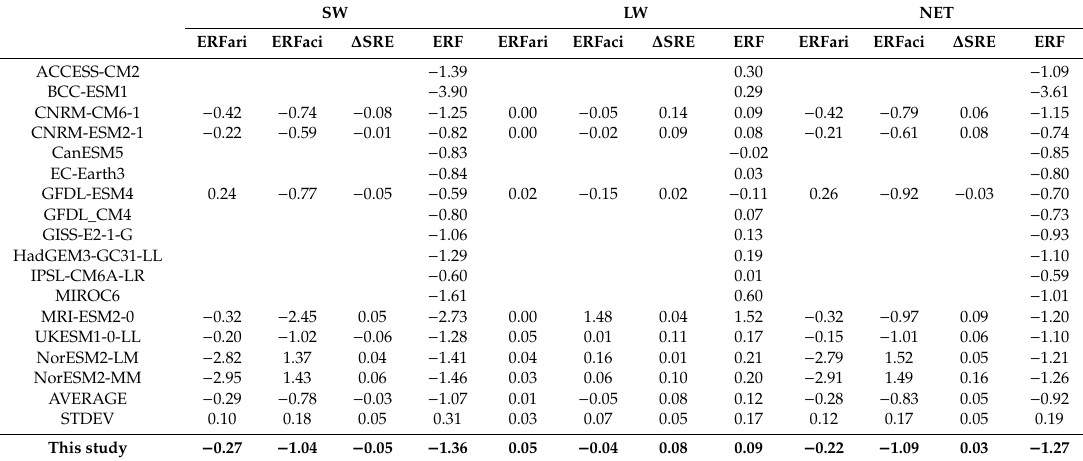
Table 1. Comparison of annual mean e ff ective radiative forcing in this study and 16 available CMIP6 model results * (unit: W m − 2